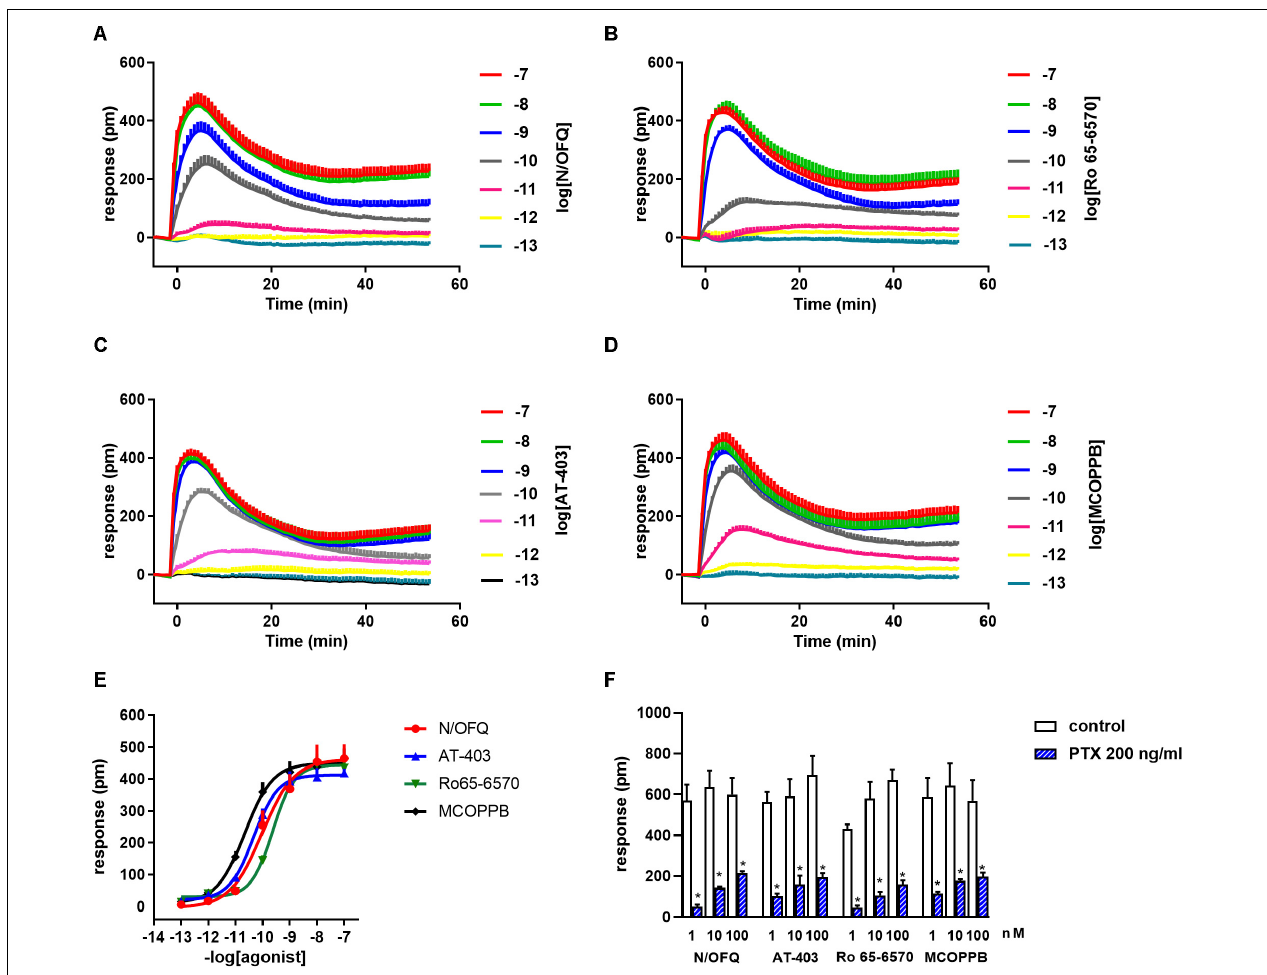
FIGURE 2 | DMR traces in response to N/OFQ (A) , Ro 65-6570 (B) , AT-403 (C) , and MCOPPB (D) . Concentration response curves to NOP receptor agonists are displayed in (E) . The effects of high concentrations of NOP agonists in the absence and presence of 200 ng/ml PTX are shown in (F) . Data are mean ± SEM of 5 experiments performed in duplicate and of 3 experiments performed in duplicate (F) . Two-way ANOVA (agonist × PTX) revealed an effect of PTX F ( 1 , 47 ) = 352. * p < 0.05 vs. control, Tukey’s test.